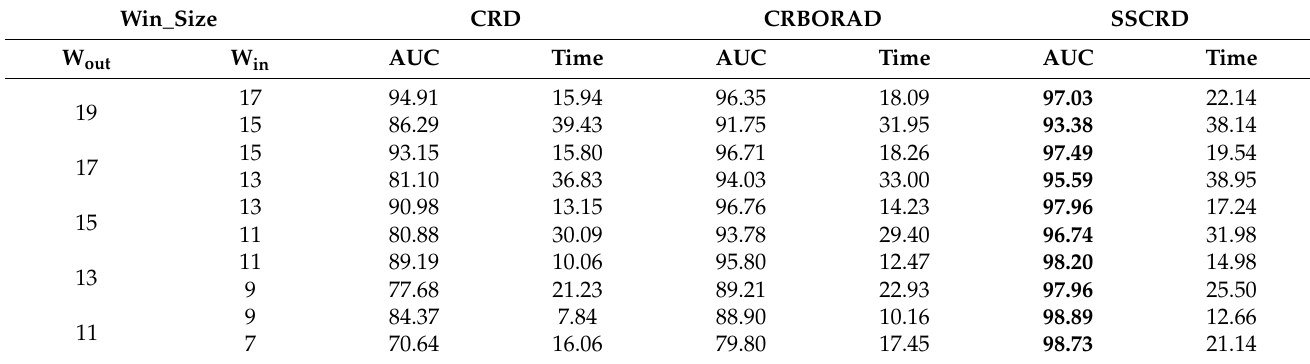
Table 3. AUC values (in %) and computing times (in seconds) for ABU Airport